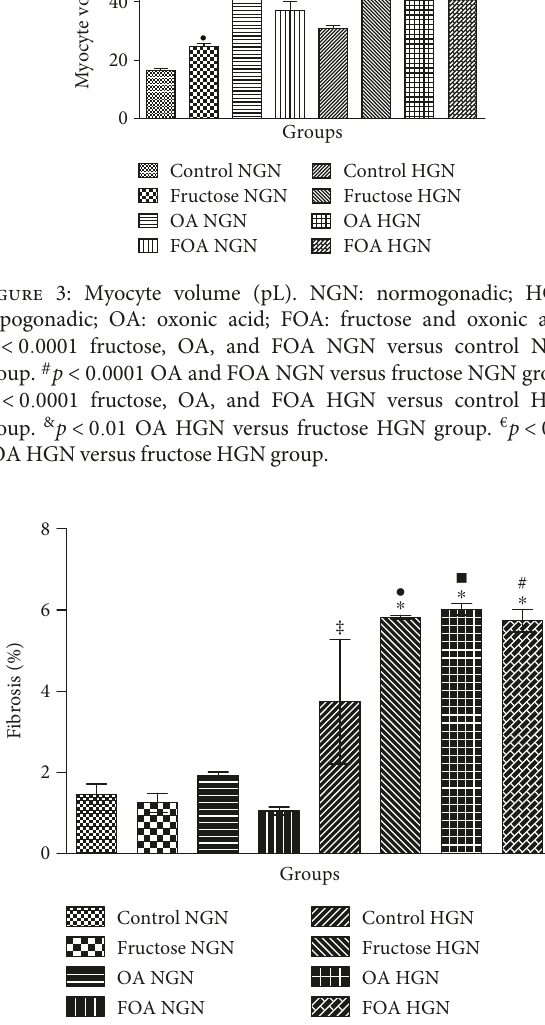
Figure 4: Percentage of cardiac fi brosis. NGN: normogonadic; HNG: hypogonadic; OA: oxonic acid; FOA: fructose and oxonic acid. ∗ p < 0 001 F, OA, and FOA HGN versus control HGN group. ‡ p < 0 0001 control HGN versus control NGN group. (cid:129) p < 0 0001 fructose HGN versus fructose NGN group. ■ p < 0 0001 OA HGN versus OA NGN group. # p < 0 0001 FOA HGN versus FOA NGN